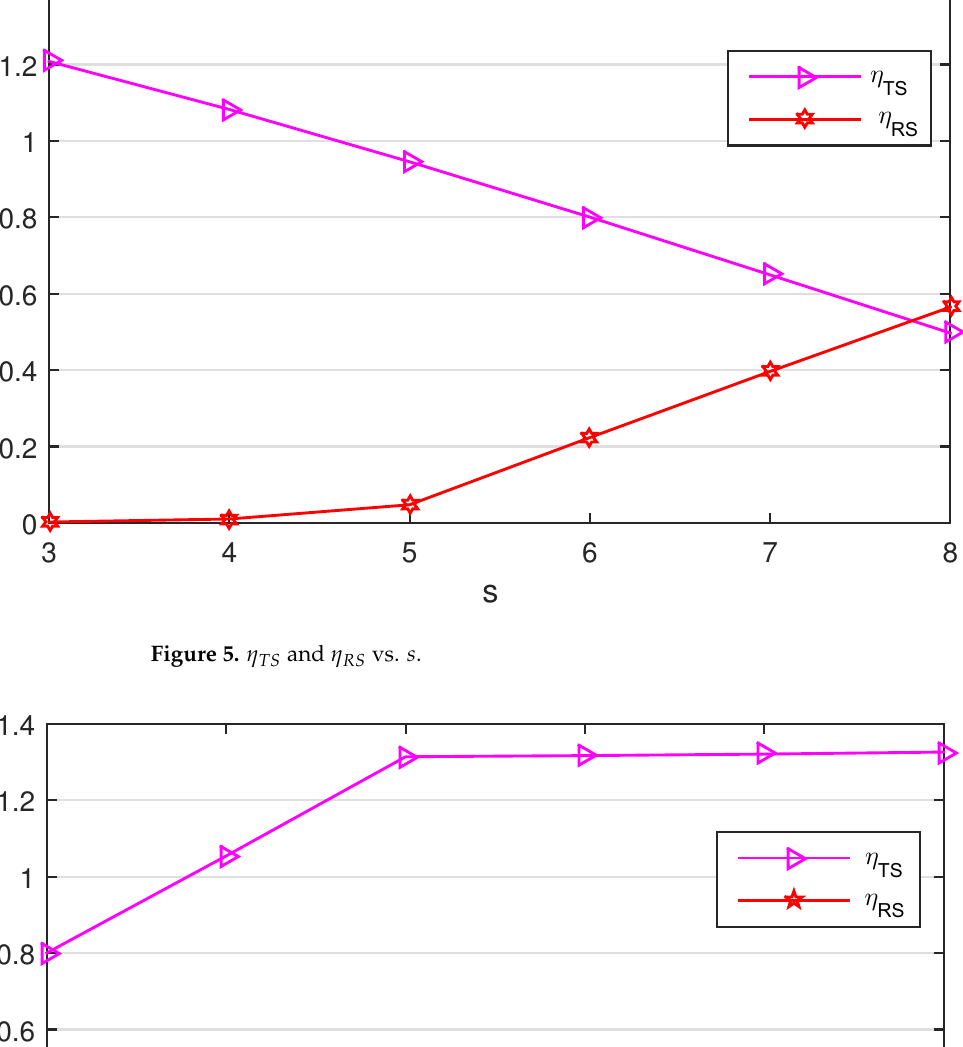
Figure 6. η TS and η RS vs. r